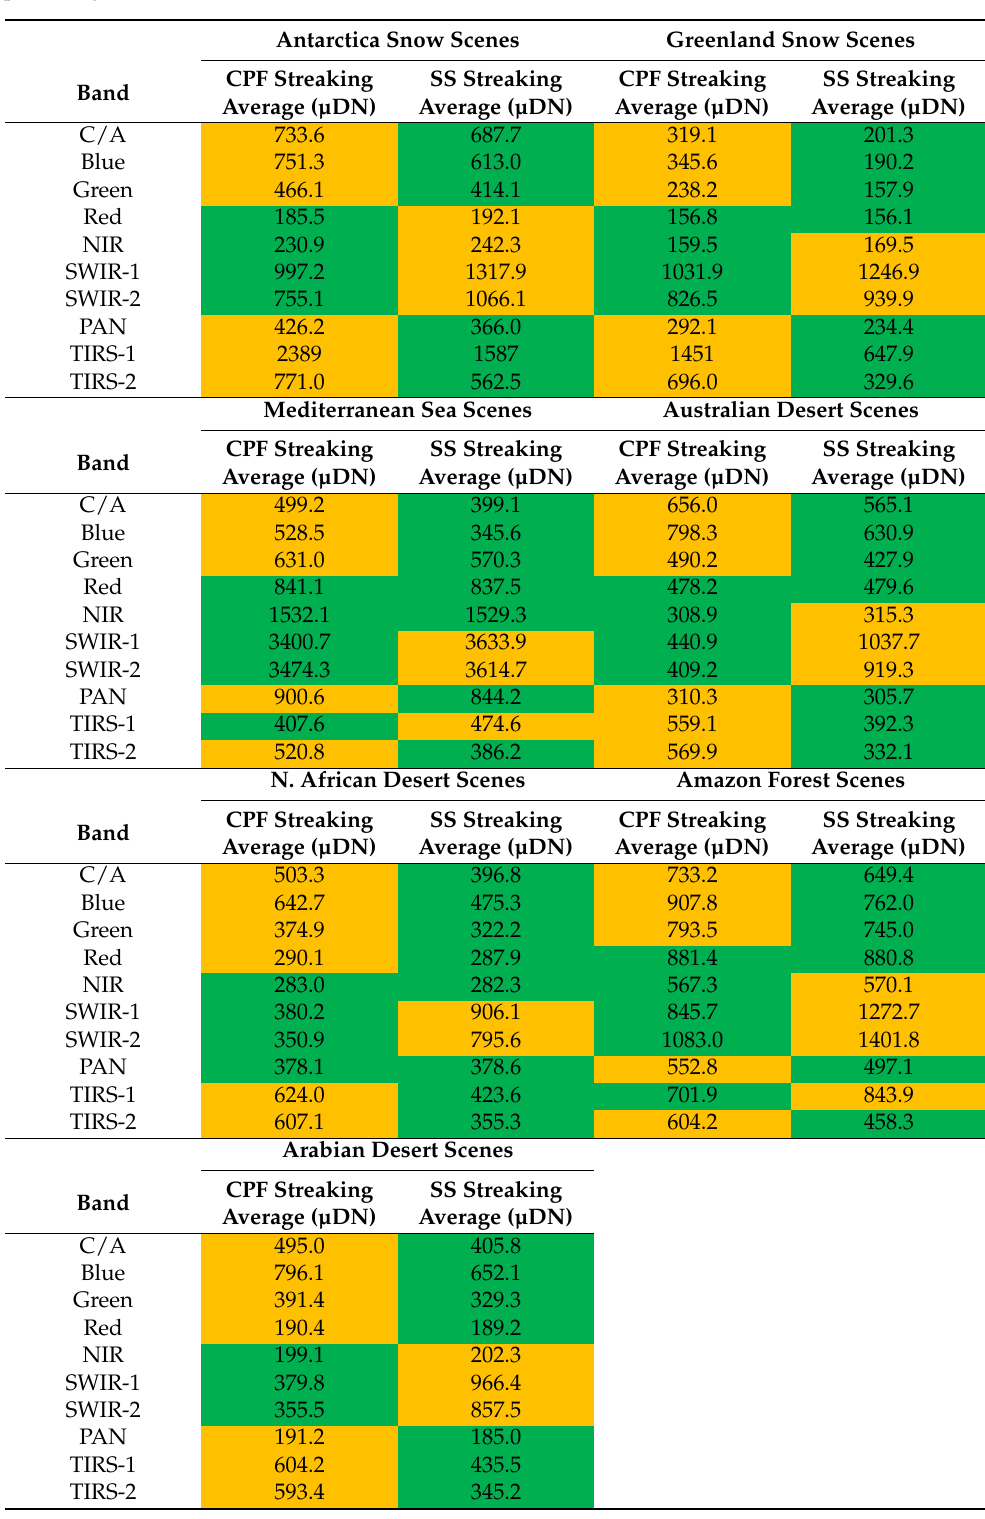
Table A2. Complete table of CPF-to-SS Streaking Metric comparison; yellow cells contain statistically worse data than green cells; if multiple cells are the same color that data is statistically equal, as proven by the t